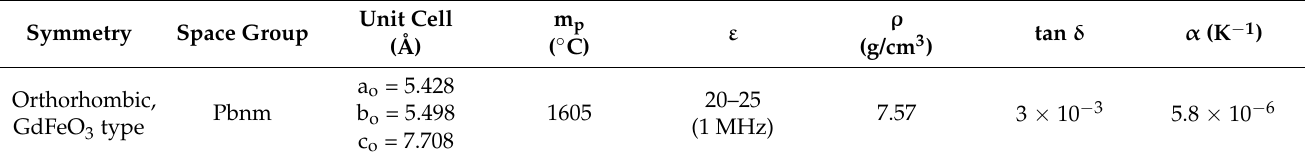
Table 1. Room temperature structural and physical properties of bulk NdGaO 3. m p = melting point, ε = dielectric constant, ρ = density, tan δ = dielectric loss, α = linear thermal expansion coefficient.